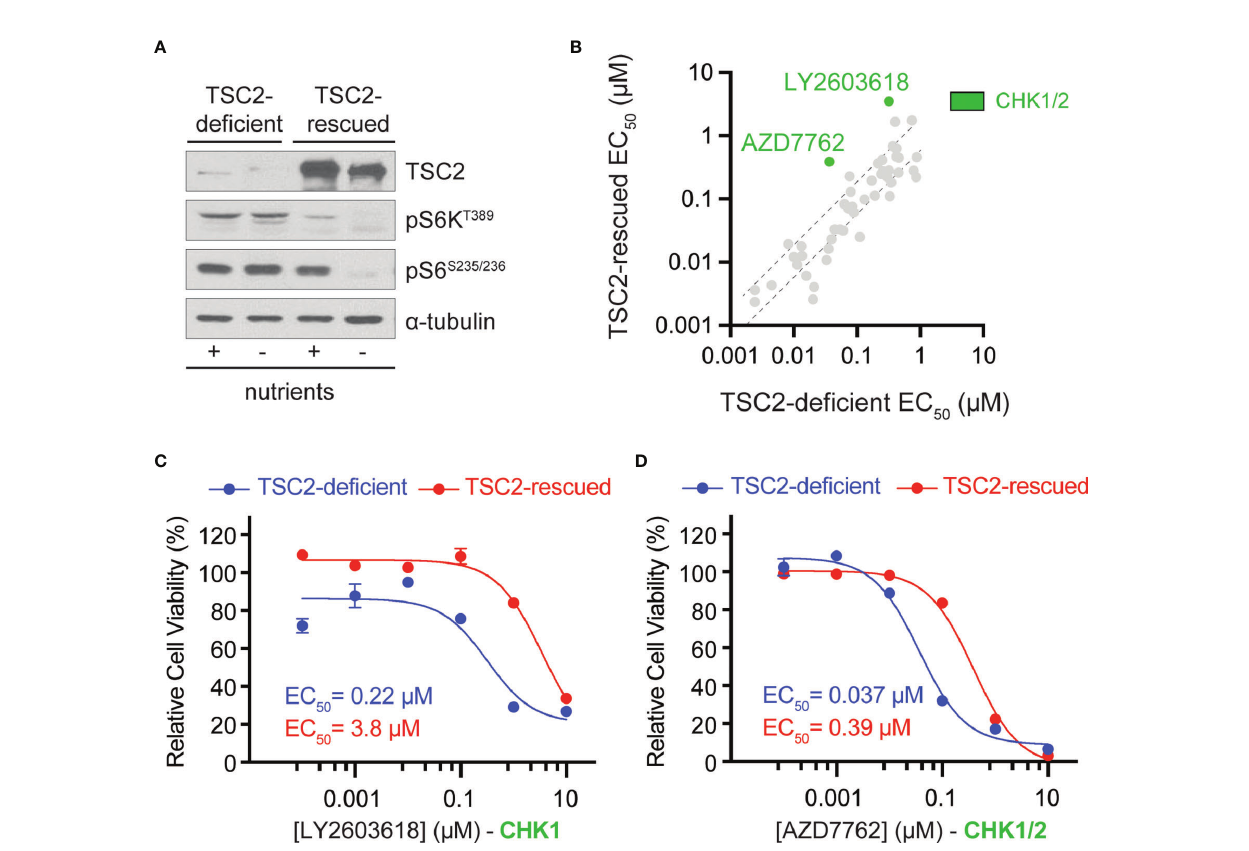
FIGURE 1 | Chemical compound screen identi fi es sensitivity to checkpoint kinase inhibition in TSC2-de fi cient cells. (A) Western blots from TSC2-de fi cient (621-102) or TSC2-rescued (621-103) cells cultured with (+) or without (-) nutrients. (B) Scatter plot of EC 50 values after chemical compound screens in TSC2-de fi cient (x-axis) vs. TSC2-rescued (y-axis) cells with >60% reduction in viability and an EC 50 value <1 µM in TSC2-de fi cient cells; dashed black lines represent the 99% con fi dence interval for the linear regression. CHK1/2, checkpoint kinase 1/2, inhibitors (green). (C, D) Dose – response curves for the indicated CHK inhibitors LY2603628 (C) and AZD7762 (D) in TSC2-de fi cient (blue) or TSC2-rescued cells (red) after 72 h; data are presented as mean ± s.e.m (n =